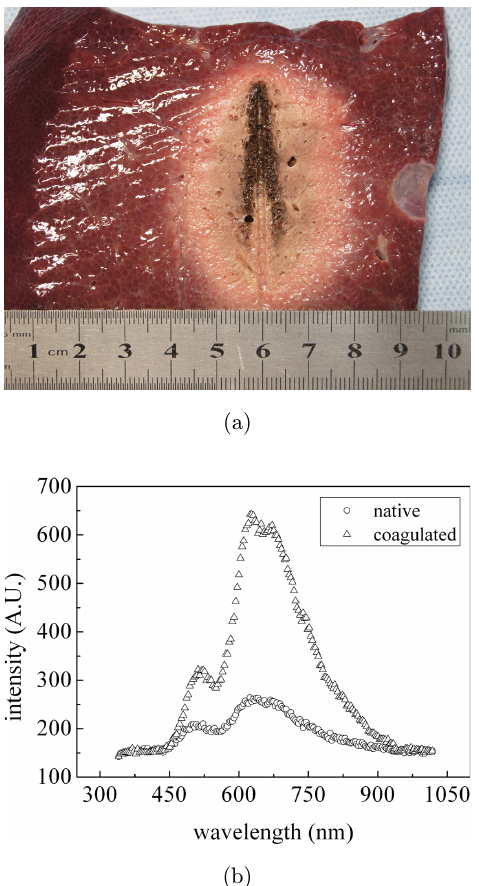
Fig. 3. (a) Ablated liver section and (b) measured spectrum of native and coagulated tissue.